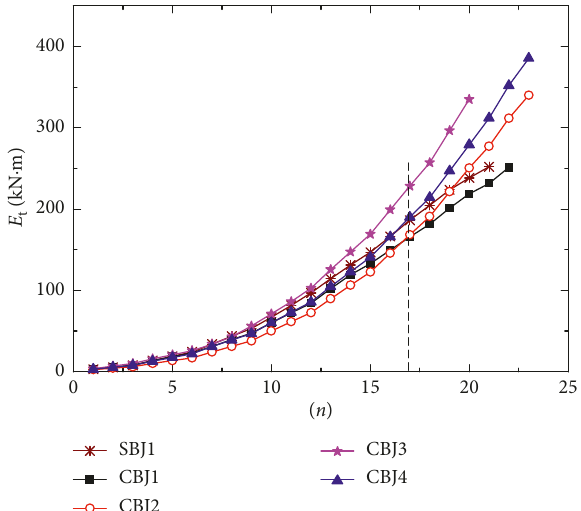
Figure 20: Accumulated energy dissipation.